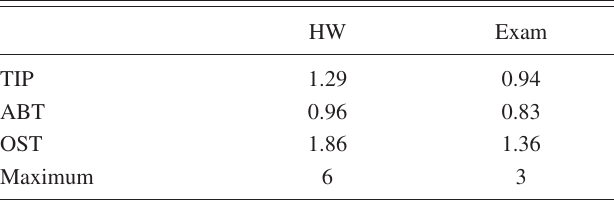
TABLE II. Mean facet difference score for each tutorial on each post-test assessment. Larger value indicates more improvement. The maximum correction value for each assessment is displayed at the